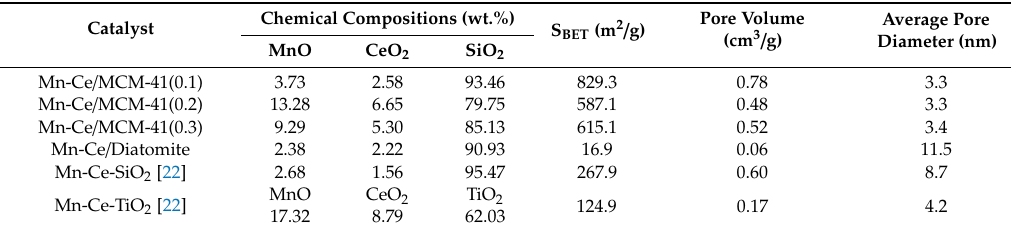
Chemical compositions of catalysts, specific surface area and pore structure of Mn-Ce / MCM-41 catalysts. Chemical Compositions (wt.%) Catalyst